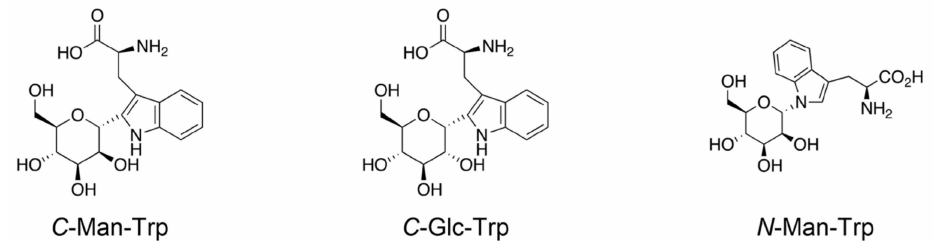
Figure 1. The structures of C -mannosyl tryptophan ( C -Man-Trp), C -glucosyl tryptophan ( C -GlC-Trp), and N -mannosyl tryptophan ( N